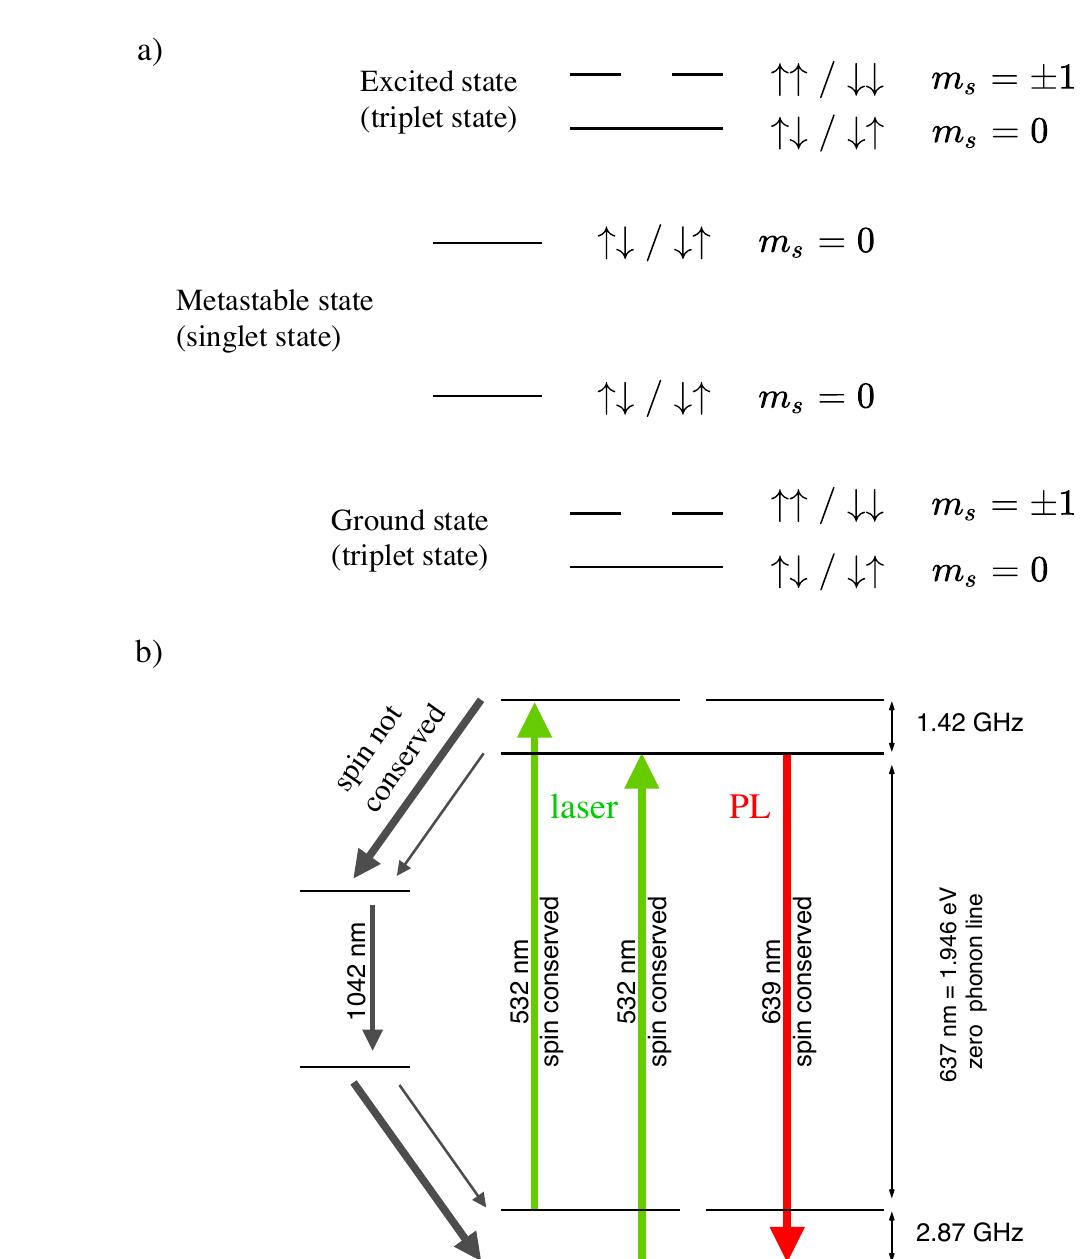
Figure 2. Energy levels scheme of a NV − center. ( a ) Ground and excited states are split by spin interaction into a triplet. The electron is a fermion, its spin quantum number has a magnitude of s = 1/2 and two possible magnetic component m s = ± 1/2. The two electrons in the NV − center exist in a triplet state: one state where electrons have opposite spins ( m s = 0), and two degenerated states with electrons spin pointing to the same direction ( m s = ± 1) and higher energy. ( b ) The excitation (green arrows) conserves the spin and also the decay from m s = 0 excited to m s = 0 ground, however, when the center state is m s = ± 1 excited, one of the electrons flips and the state changes to m s = 0, and the decay follows (preferentially) a non radiative path through the metastable singlet states, with the emission of a 639 nm (red arrow in the picture) photon corresponding to the zero phonon line (ZPL) and the decay from m s = ± 1 with the emission of a 1042 nm (infrared, black arrows in the picture), decreasing the observed PL intensity. The energy gap between m s = 0 and m s = ± 1, in the ground and excited states, with zero field splitting, corresponds to 2.87 GHz and 1.42 GHz